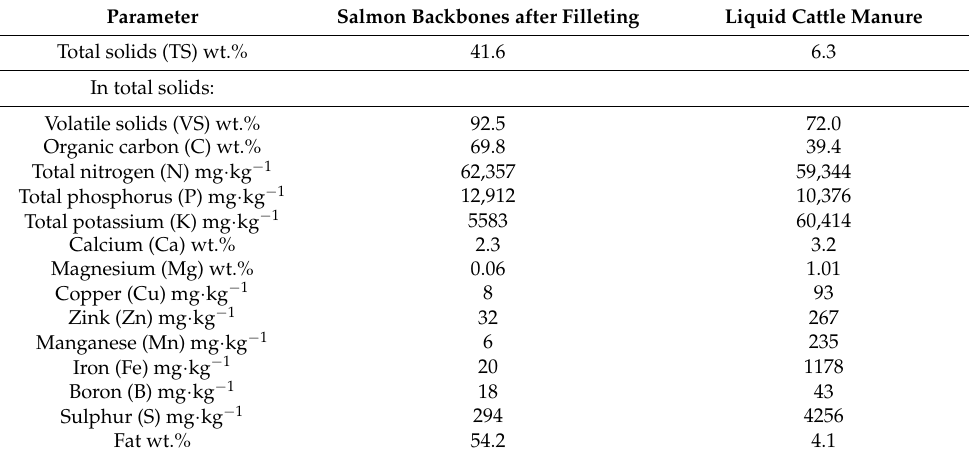
Table 3. Chemical composition of salmon backbones and cattle